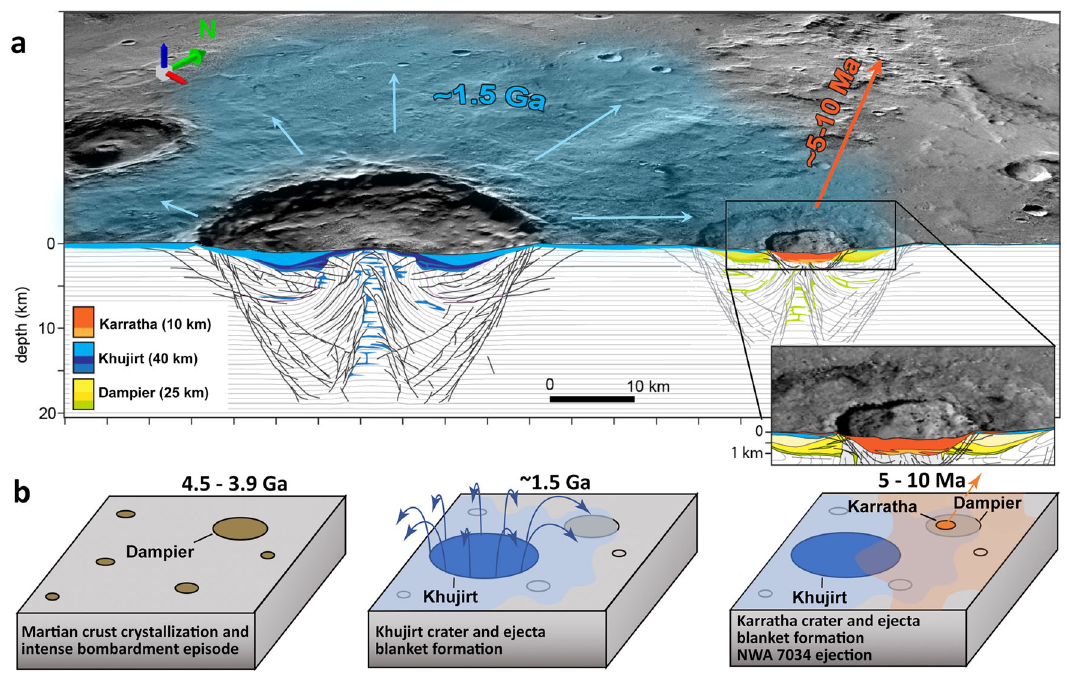
Fig. 3 The NWA 7034 launch site geological context. a Perspective view (Context Camera mosaic 21 ) and cross-section through Karratha along a SW-NE axis (Supplementary Fig. 5b) as interpreted from numerical modelling simulations. Shades of colors denote impactites (impact melt and in situ breccia; ejecta and fall-back breccia). b Schematic of chronological events experienced by the host terrain of the regolith